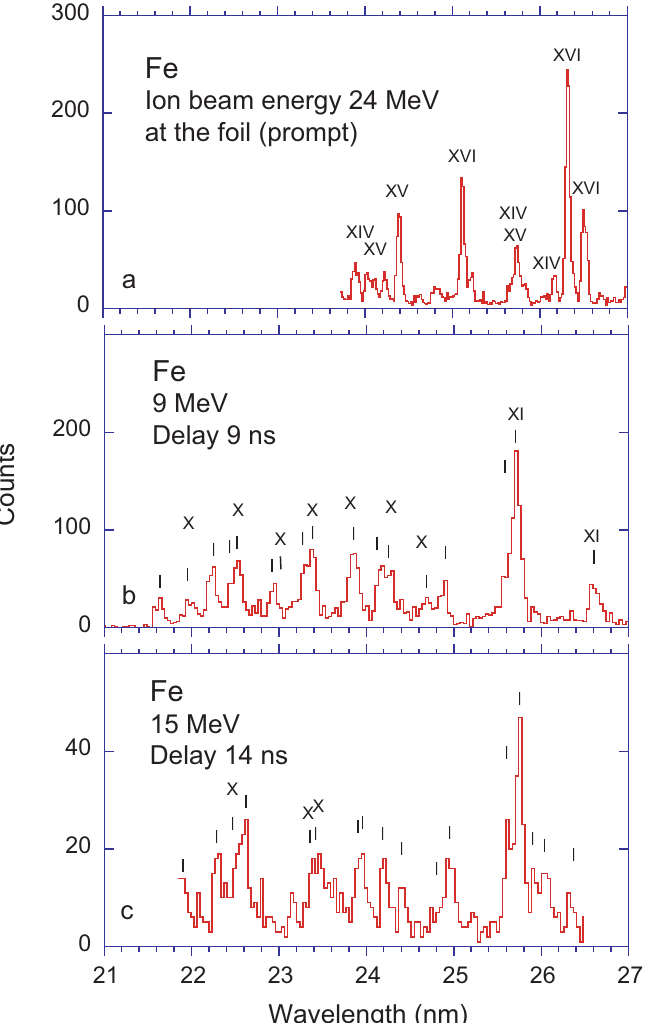
Figure 16. Prompt and delayed beam–foil spectra of Fe at various ion beam energies. The strongest lines are identified by the spectrum number (based on [59]). Unidentified lines are marked by a fiducial. The charge state distribution is centered on q = 11 + , and ion charge states q = 8 + to q = 14 + are expected to contribute. ( a ) Observation at the foil, slit width 80 µ m, line width (FWHM) 0.06 nm; ( b ) Observation of the ion beam 50 mm downstream of the foil, corresponding to a delay of 9 ns after the spectrum in ( a ). Slit width 150 µ m, line width (FWHM) 0.12 nm; ( c ) Observation of the ion beam 100 mm downstream of the foil, corresponding to a delay of 14 ns after the spectrum in ( a ). Slit width 120 µ m, line width (FWHM) 0.09